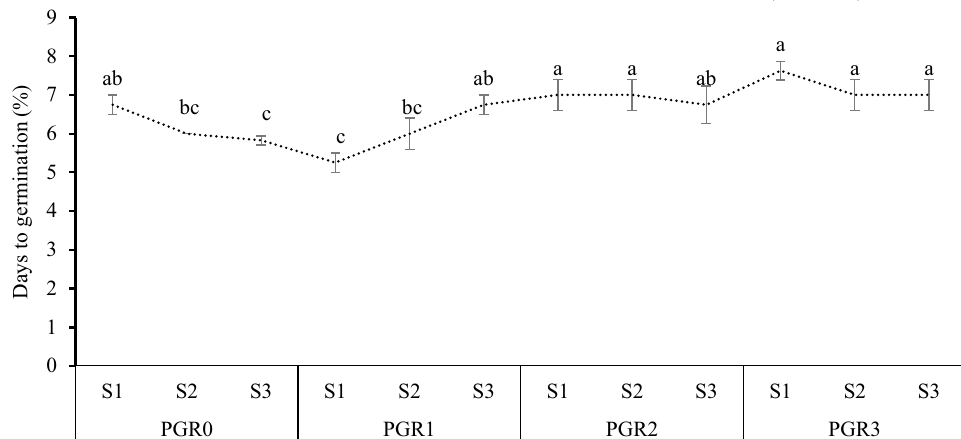
Fig. 1 Effect of plant growth regulators at different stages on days to germination (%). Abbreviations are as follows: PGR 0 : 0, PGR 1 : 100 mgL − 1 GA 3 , PGR